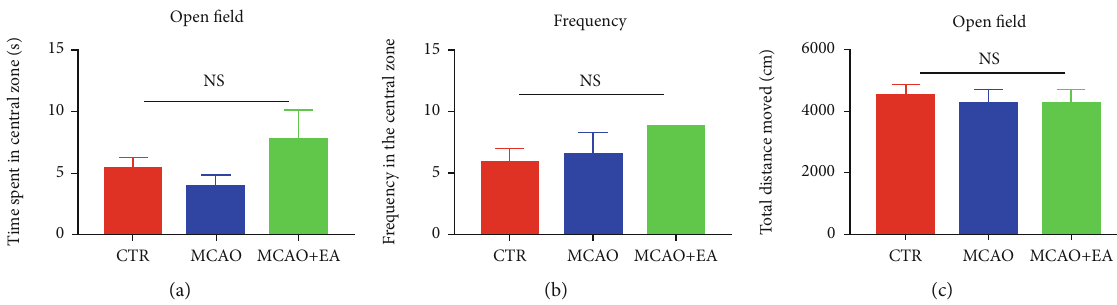
Figure 5: E ff ects of the MCAO and EA in the open fi eld test. Time spent in the central zone (a), frequency in the central zone (b), and total distance moved (c). Data are expressed as mean ± SEM ( n = 10 each group). NS: no signi fi cance; CTR: control; MCAO: middle cerebral artery occlusion; EA: electroacupuncture.